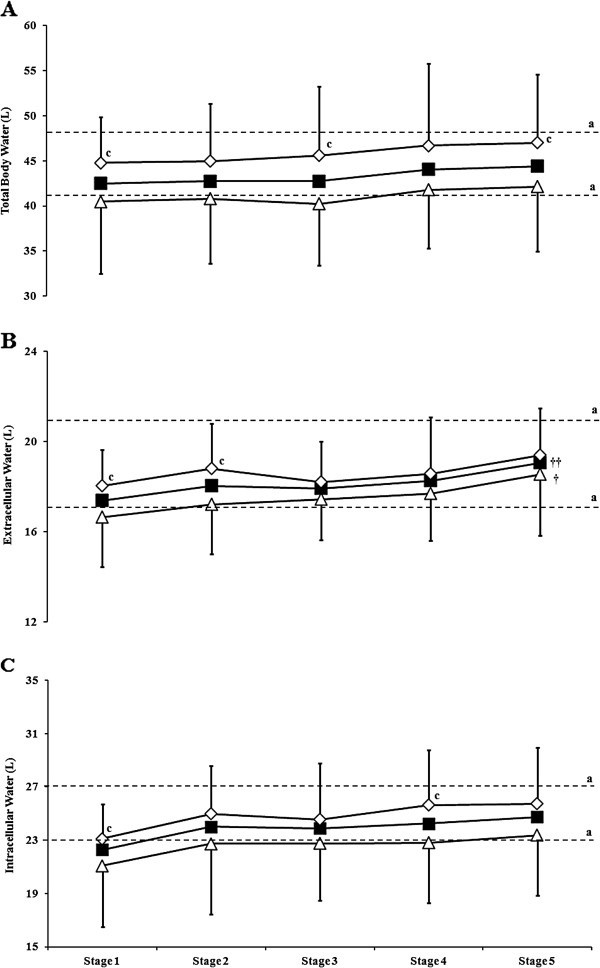
Changes in pre-stage resting body water of UER along MSUM competition. (A) Total body water, (B) Extra-cellular water, (C) Intra-cellular water. Mean (SD): UER (■, n = 43); slow runners (SR ∆; MSUM mean speed <8 km/h, n = 23); fast runners (FR ◊; MSUM mean speed ≥8 km/h, n = 20). a Normal physiological range (Quadscan 4000, Bodystat, Douglas, Isle of Man, UK). †† p < 0.01 and † p < 0.05 vs. Stage 1; cp < 0.05 vs. SR.